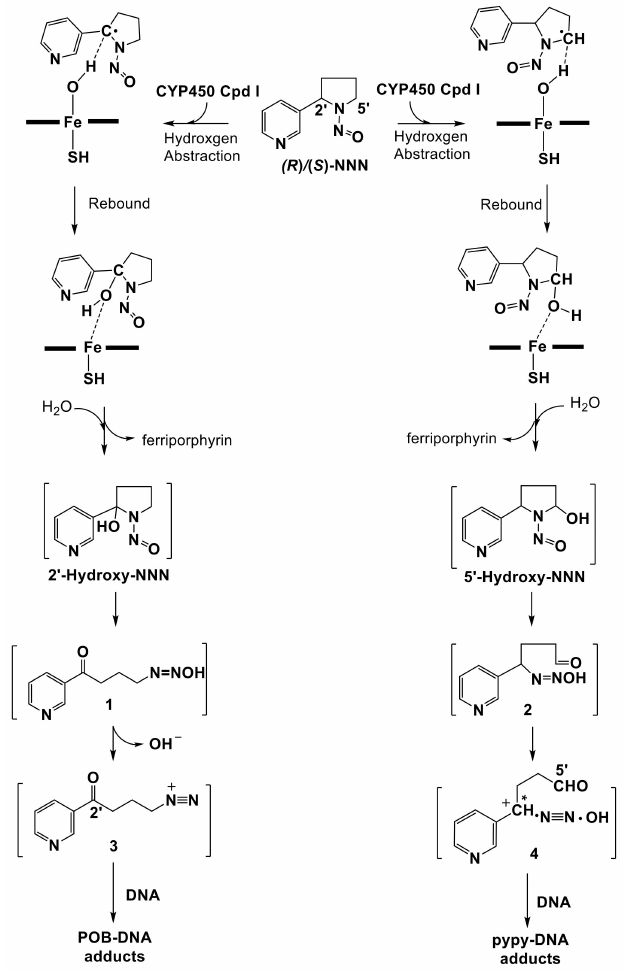
Figure 1. Mechanism of metabolic activation of NNN and the formation of DNA